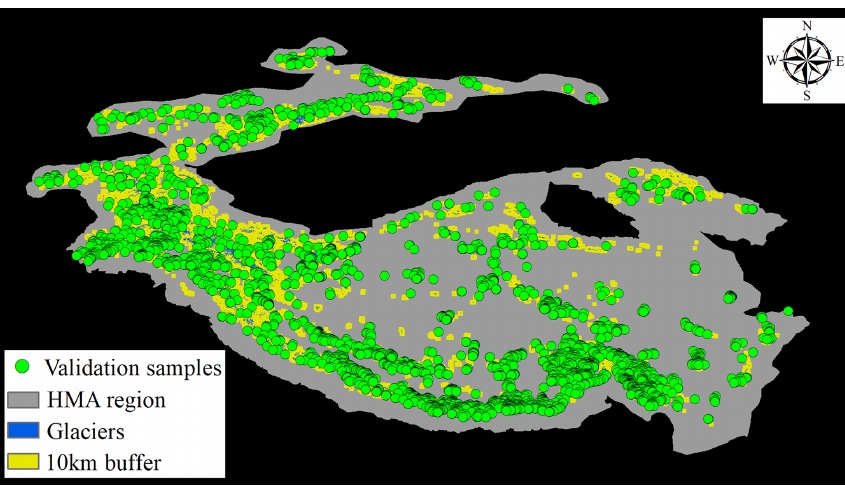
Figure A5. Distribution of validation samples selected using stratified random sampling. Blue polygons are glacier outlines taken from the Randolph Glacier Inventory (RGI v5.0), the Second Chinese Glacier Inventory (CGI2), and the GAMDAM inventory. Yellow polygons refer to buffer areas within 10km of glacier terminals.